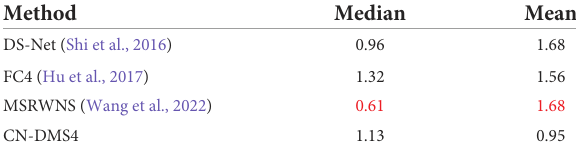
TABLE 6 Quantitative evaluation on ADE20k (Zhou et al., 2016), red indicates the best.